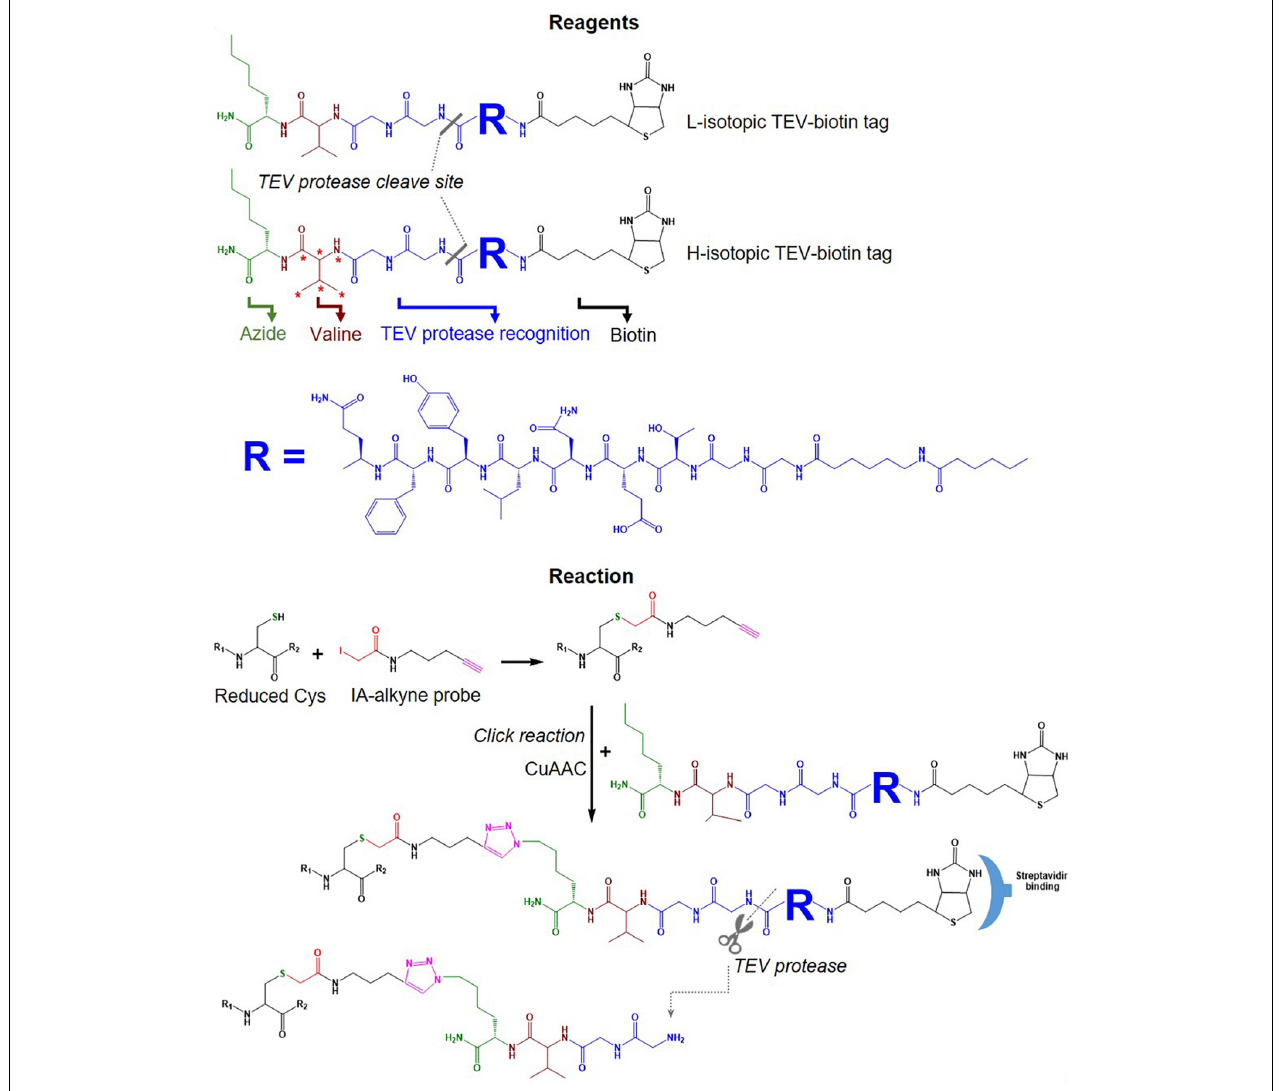
FIGURE 7 | Tags used in the isoTOP-ABPP workflow. Structure of light and heavy isotopic TEV-biotin tags used in isoTOP-ABP, their reaction with reduced Cys, purification using streptavidin and release of labeled proteins using TEV